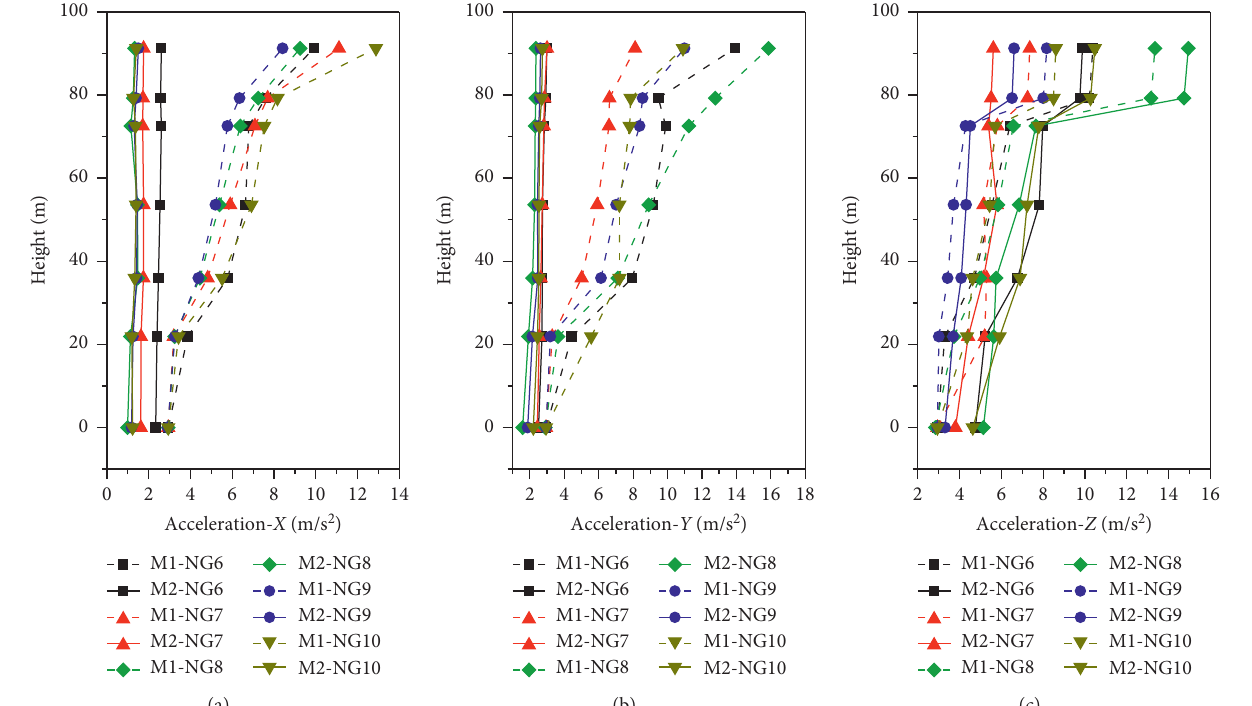
Figure 14: Comparison of peak acceleration along the height of structure under NG6-NG10: (a) X -direction, (b) Y -direction, and (c) Z -